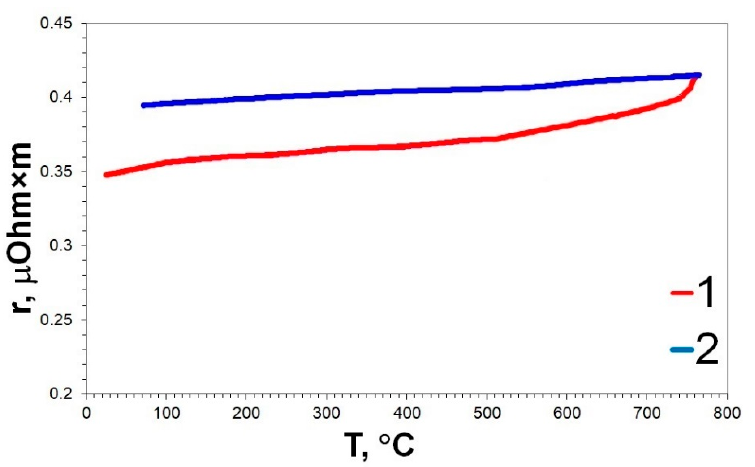
Figure 7. Temperature dependence of the electrical resistivity of the Cu-Pd50 foil in the heating (1)- cooling cycle (2).